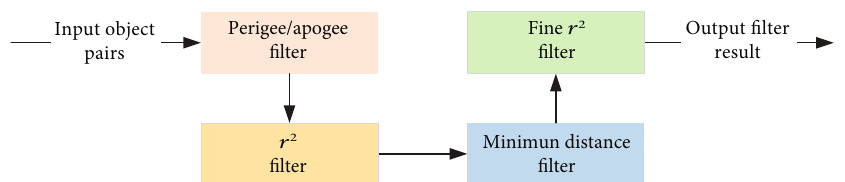
Figure 15: The robust object fi lter process in this case based on di ff erent literature and